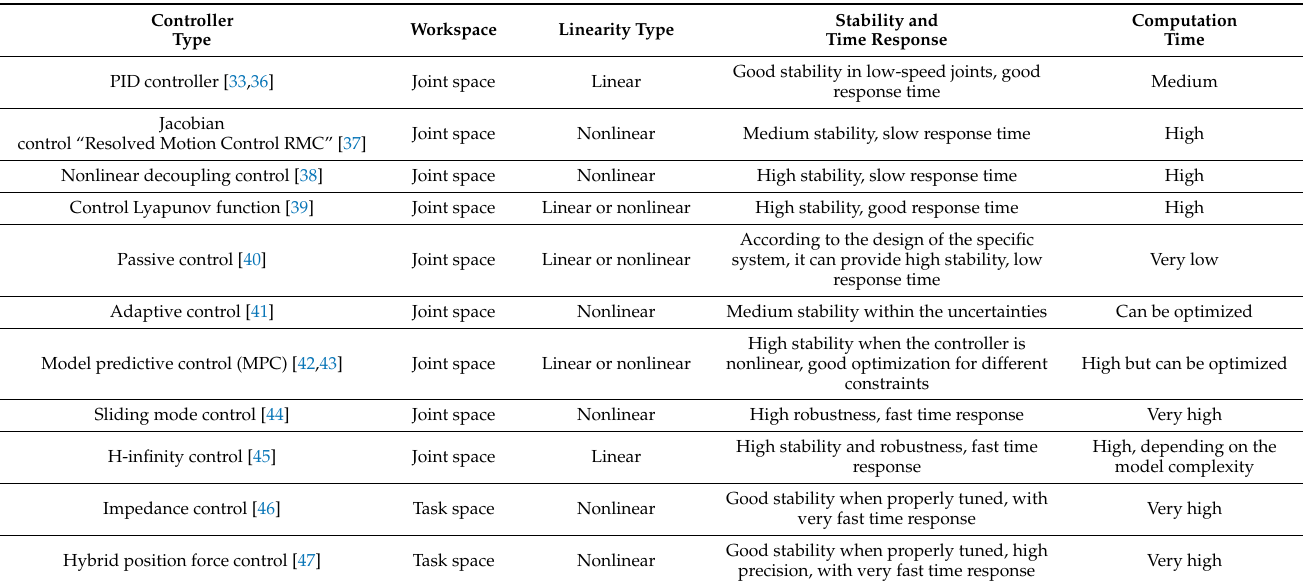
Table 1. Most commonly used control approaches used for industrial robot